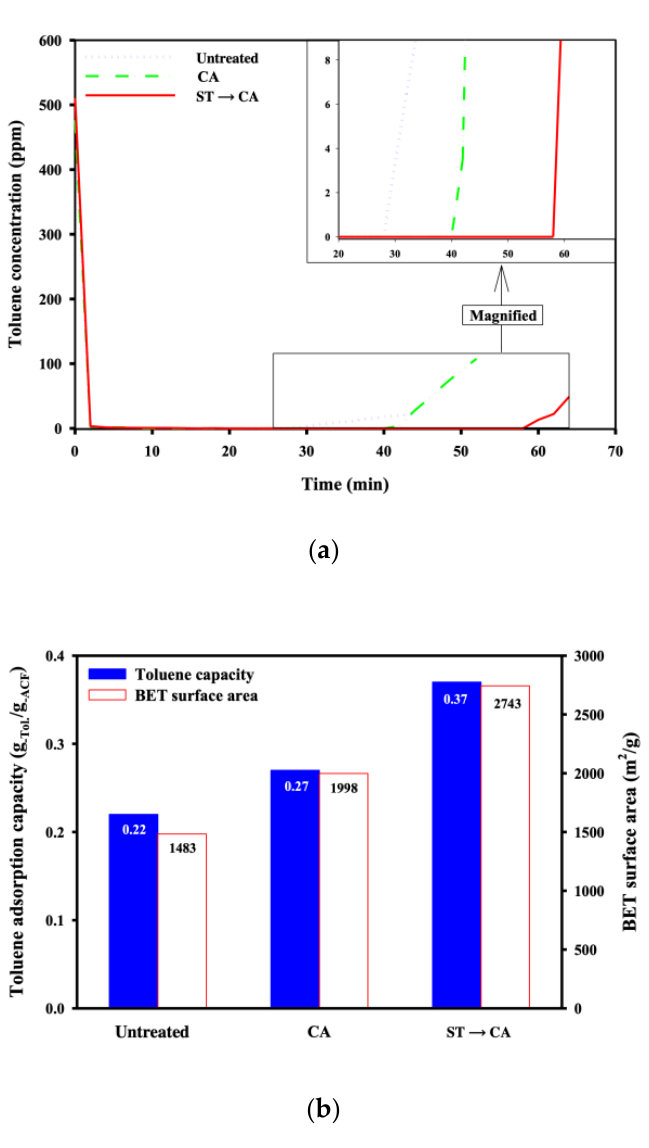
Figure 9. ( a ) Breakthrough curves and ( b ) adsorption capacity of ACFs for toluene and BET surface areas of ACFs (Untreated, untreated ACFs; ST, ACFs prepared in the surface treatment for 80 min;